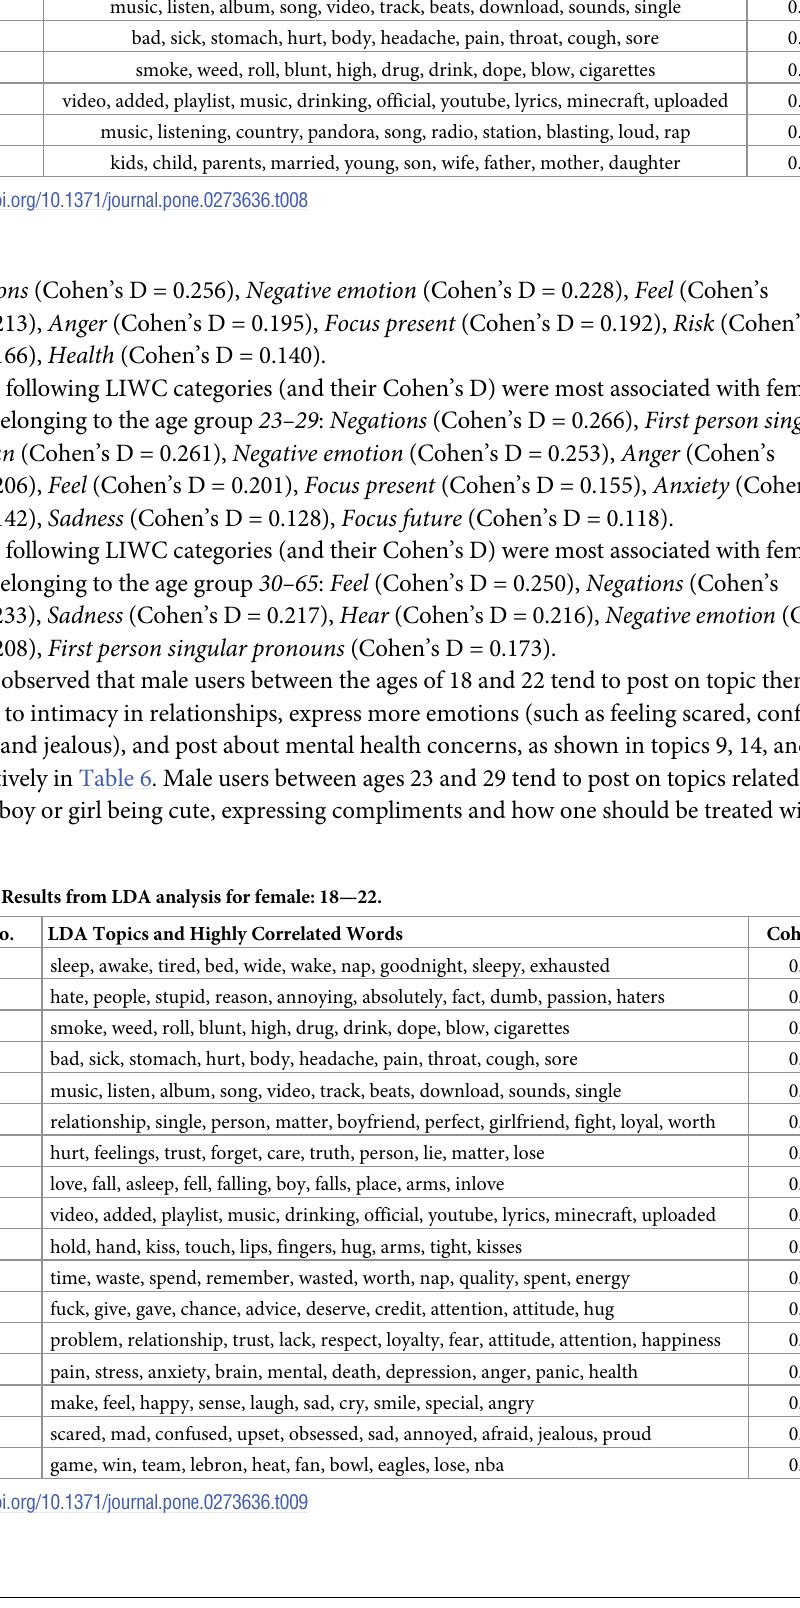
Table 8. Results from LDA analysis for male: 30—65. Topic